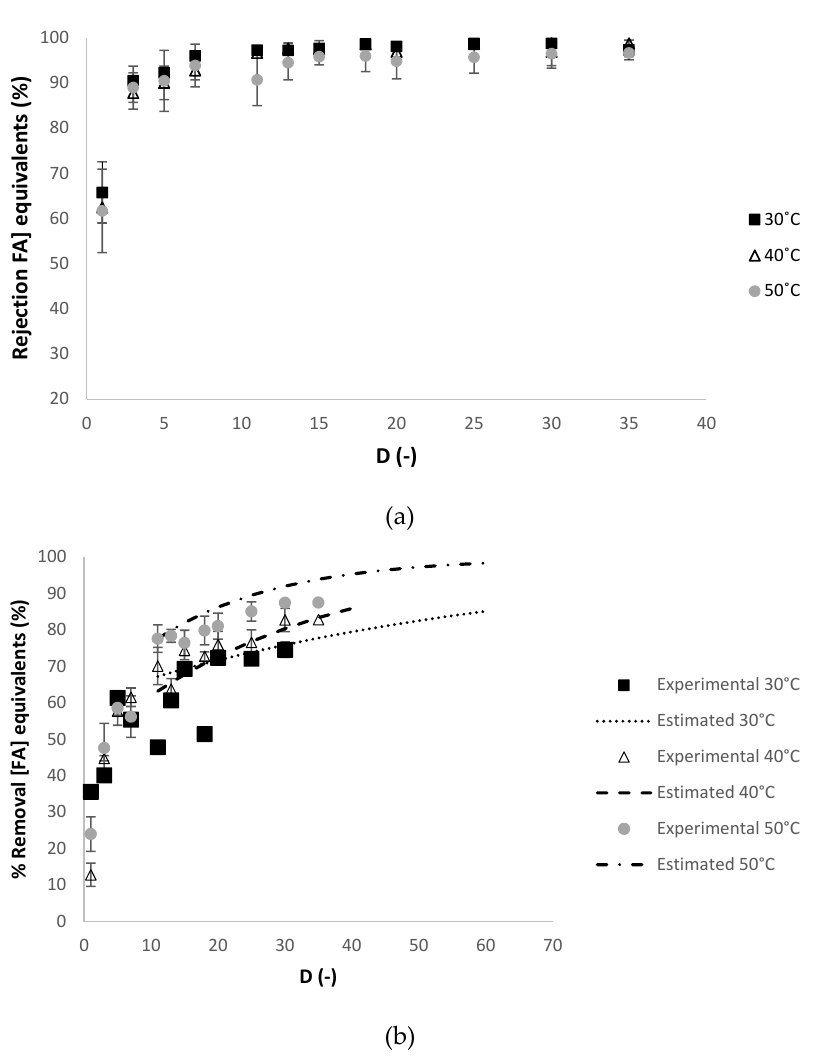
Figure 4. Dia-ultrafiltration experiment at 30 ◦ C, 40 ◦ C and 50 ◦ C with a (diluted) arabinoxylans fraction as feed, without membrane relaxation procedure: ( a ) R FA (% FA.eq), apparent rejection for contaminants equivalents and ( b ) percentage of removal of charged contaminants in ferulic acid equivalents (FA.eq) against the D (-) diafiltration volume. Each analysis had duplicate